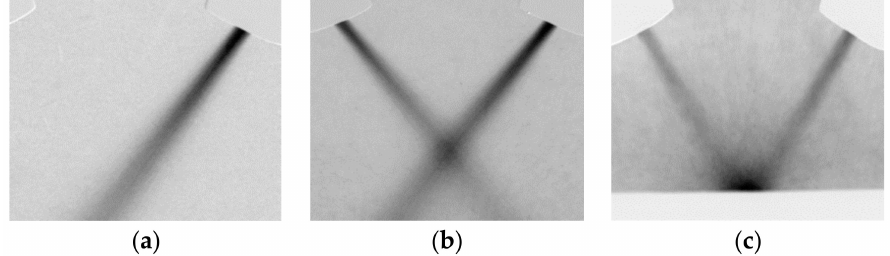
Figure 3. ( a ) One active nozzle; ( b ) two active nozzles; ( c ) two active nozzles with a substrate at 15